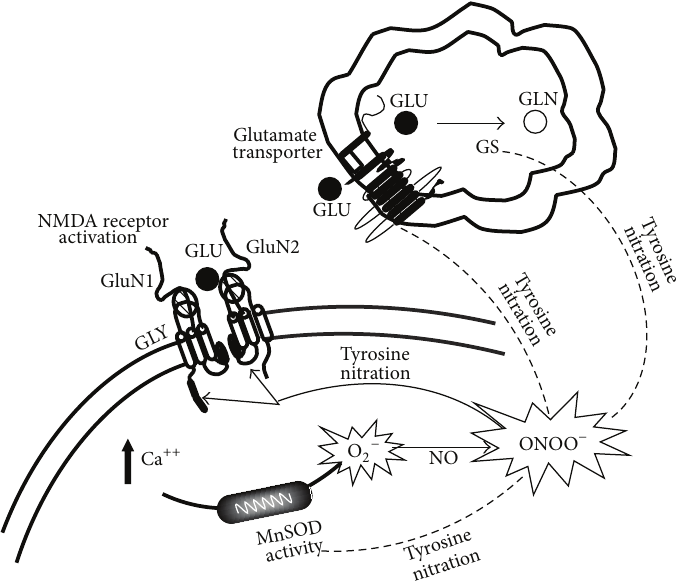
Figure 7: Nitration of tyrosine residues modulates glutamate transmission in the spinal cord. NMDAR activation increases intracellular calcium influx and leads to the production of peroxynitrite which in turn contributes to the hyperalgesic state by nitrating and subsequently activating NMDAR subunits while inhibiting GLT-1 and GS. Removal of PN by antioxidant abolished NMDA-mediated hyperalgesia by preventing tyrosine residues nitration of the glutamate